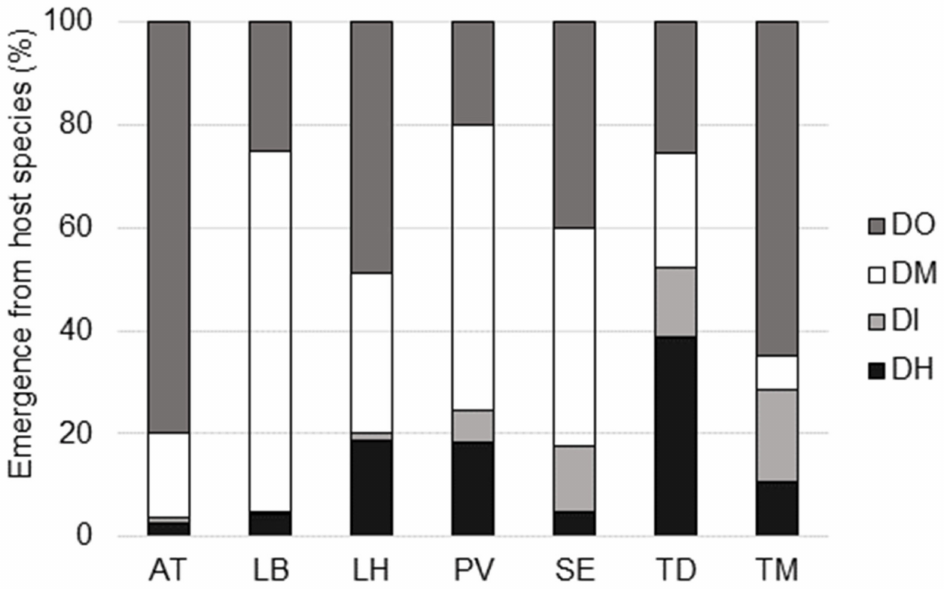
Figure 2. Host preference of parasitoid species in multi-species baited Delta-traps exposed in Ticino and Zurich in 2017. AT: Asobara tabida ; LB: Leptopilina boulardi , LH: Leptopilina heterotoma ; PV: Pachycrepoideus vindemmiae ; SE: Spalangia erythromera ; TD: Trichopria drosophilae ; TM: Trichopria modesta ; DO: Drosophila subobscura ; DM: Drosophila melanogaster ; DI: Drosophila immigrans ; DH: Drosophila hydei